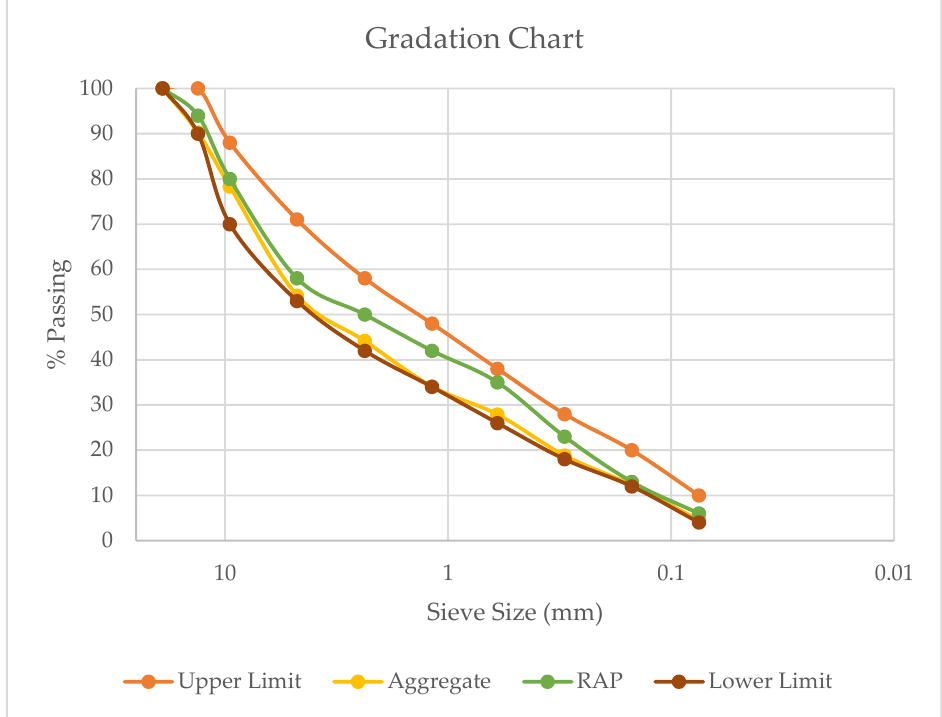
Figure 1. Gradation values of materials.